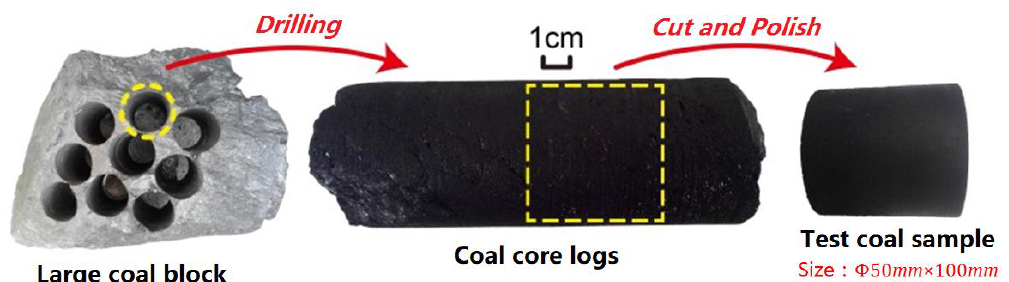
Figure 1. Samples preparation procedure.